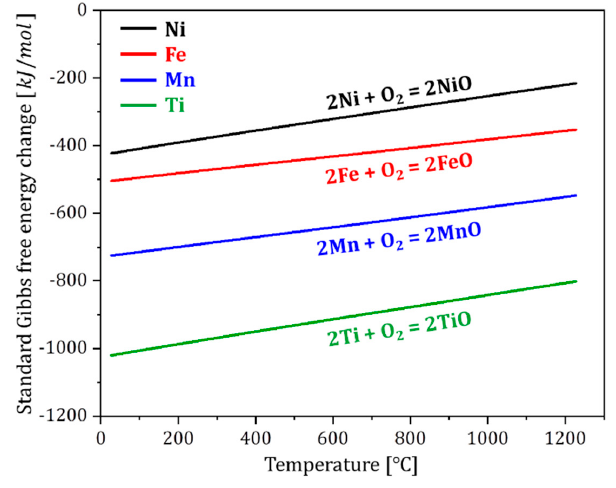
Figure 3. The Ellingham diagram of Ti, Fe, Ni, and Mn calculated by Thermo-Calc. For the purpose of directly monitoring the evolution of the thin oxide film during heat treatment, in situ XPS was then performed at temperatures ranging from room temperature to 600 °C for the reference and substituted alloys (Figures 4–6). The initial mixed ionization state of the as-cast TiFe alloy at RT, characterized by Ti 4+ and Fe 2+ peaks, started to experience changes at a temperature as low as 200 °C (Figure 4). A slight broadening of Ti 2+ peaks could be observed, indicating the initiation of TiO 2 reduction. In parallel, the first occurrence of Fe 0 could be noted, coexisting with Fe 2+ . By rising the temperature to 300 °C, the multiplicity of the Ti valence state became even clearer as the peak noticeably broadened. Ti 2+ made its first apparition and mostly contributed to the observed peak, while Ti 4+ decreased significantly. Due to the broad aspect of the Ti2p spectra, it is rather difficult to claim a substantial contribution from the Ti 3+ state, never- theless, its existence can be assumed considering the tiny shoulder observed. Further- more, Fe2p was dominated by Fe 0 , since the contribution from Fe 2+ was negligible. At 400 °C, all Ti seemed to be in the Ti 2+ state (although it was difficult to tell if Ti 3+ remained due to the peak broadness), while Fe was mostly metallic (Fe 0 ). Beyond this point (for 500–600 °C), Ti 2+ intensified and Ti 4+ vanished, whereas the relative Fe 0 contribution appeared to decrease due to possible Ti enrichment of the surface [34], which is also suggested by earlier results (Figure 3).